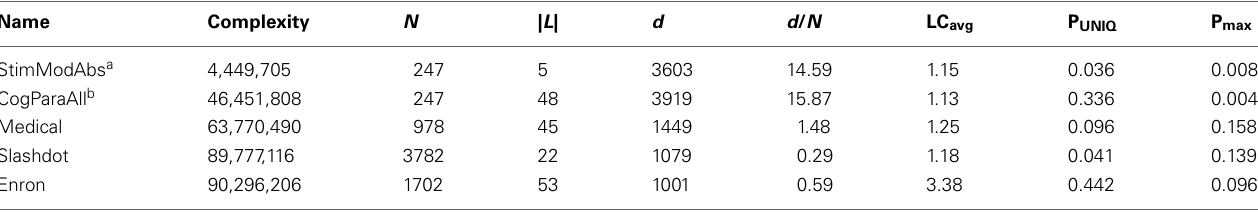
Table 4 | Characteristics of several multi-label data sets compared with